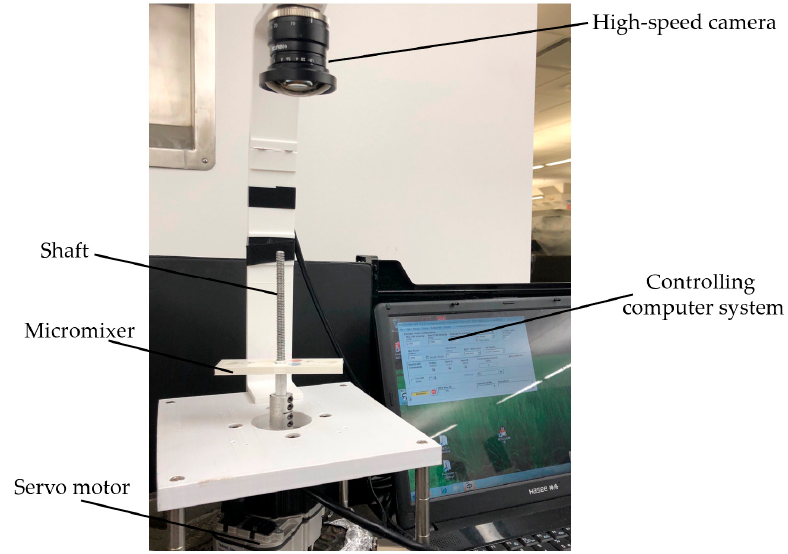
Figure 5. The experimental setup of the centrifugal platform with 3D microfluidic cartridge mounted.